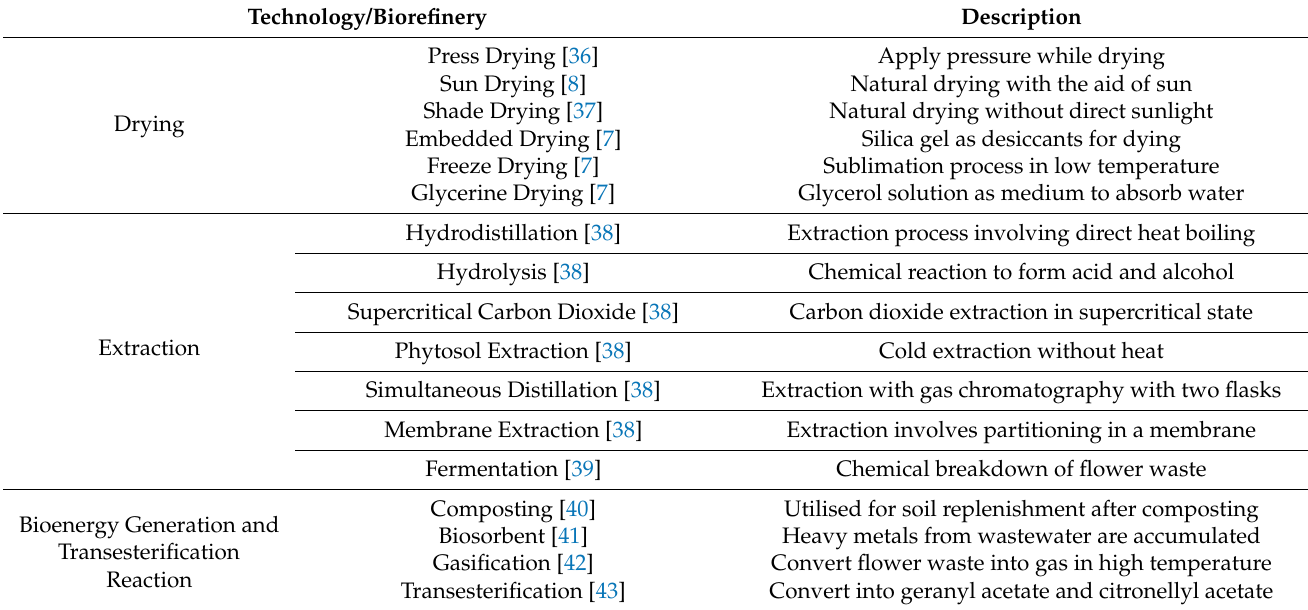
Table 3. Summary of flower-waste